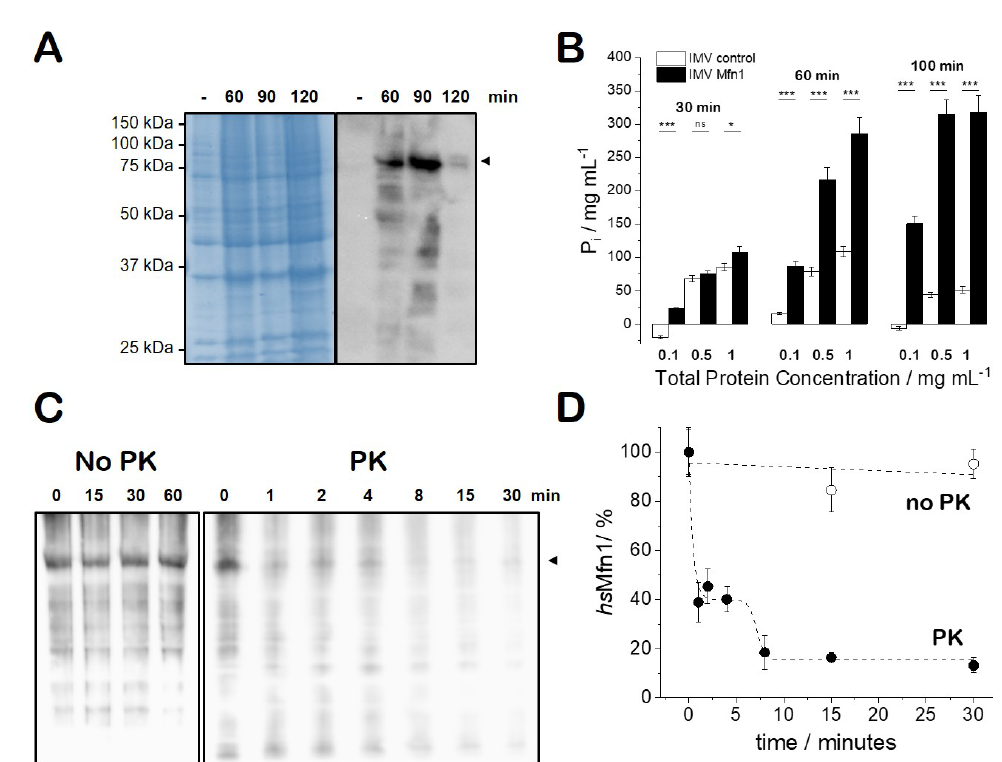
Figure 1. Characterisation of histidine-tagged full length human Mfn1 protein produced in E. coli SF100(DE3) strain. ( A ) 12% SDS-PAGE (left) and Western blot (right) with E. coli SF100(DE3)+/pTL2 cells before (-) or after (60, 90 120 min) after the addition of 1 mM IPTG. The arrowhead indicates the position of hs Mfn1 ( ∼ 82 kDa); ( B ) GTPase activity of Mfn1-IMVs supplemented with 10 mM GTP and incubated as indicated at 37 ◦ C before developing with malachite green GTPase hydrolysis assay of E. coli IMVs in the presence of 10 mM of GTP. IMVs with a total protein concentration of 0.1, 0.5 and 1 mg/mL in the absence (white bars; control) and presence of hs Mfn1 (black bars) were incubated for 30, 60 and 100 min at 37 ◦ C. Student’s t-test was performed to measure the significance of statistical difference between the different groups. p ≤ 0.05, ( ∗ ) and p ≤ 0.001, ( ∗ ∗ ∗ ) were considered statistically significant. ( C ) Protease protection assay of Mfn1-IMVs at a total protein concentration of 1 mg/mL in the absence (No-PK) or presence of 0.1 mg/mL of PK. IMVs No-PK were incubated at 37 ◦ C and IMVs PK were incubated at 4 ◦ C to be able to follow the breakdown. ( D ) Time evolution of protein breakdown as quantified from the protein band intensity during PK